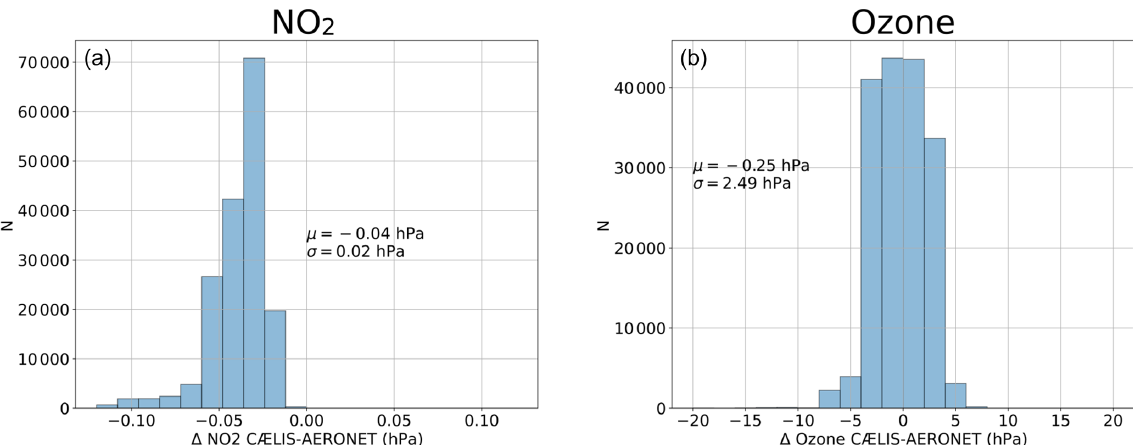
Figure 6. Frequency histogram of the differences between CÆLIS and AERONET databases for (a) NO 2 climatology and (b) O 3 climatol- ogy. Data in Dobson units